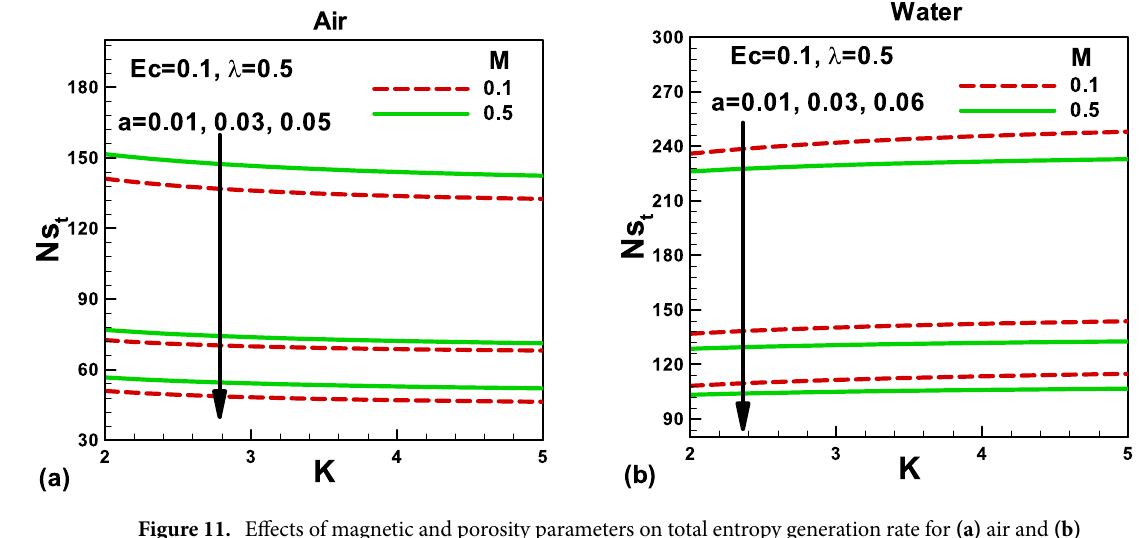
Figure 11. Effects of magnetic and porosity parameters on total entropy generation rate for (a) air and (b) water, when both needle and fluid are moving in the same direction.